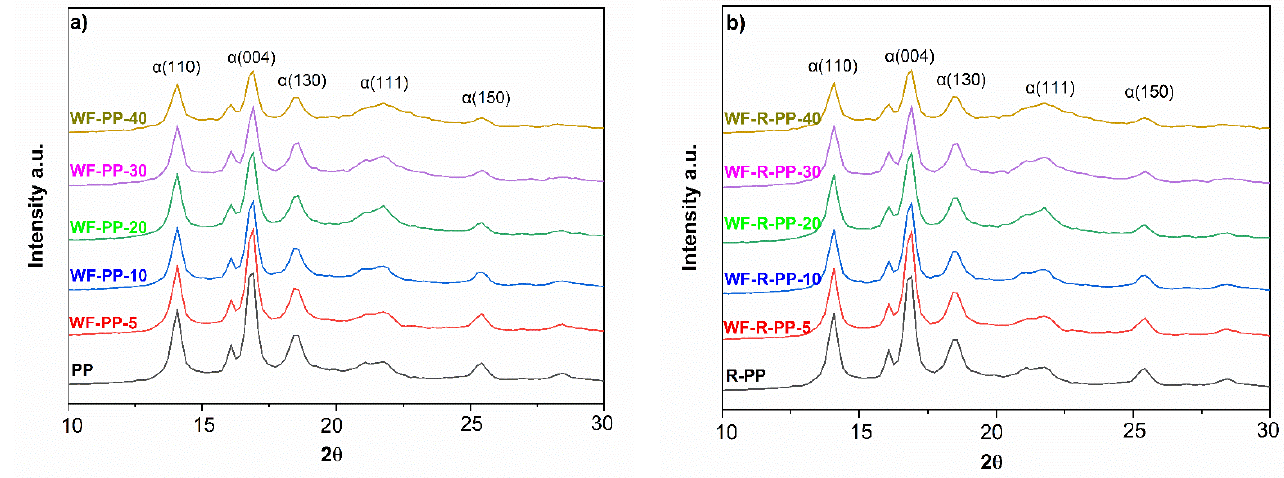
Figure 4. XRD patterns of ( a ) PP, WF-PP composites and ( b ) R-PP, WF-R-PP composites. The elemental composition of the composite surfaces was monitored by ATR-FTIR analysis. The spectra of the injection moulded samples with different addition of WF (from 5%: WF—PP − 5 to 40%: WF—PP − 40) as well as the pure PP and WF, are shown in Figure 5. As can be seen from this Figure 5, the most prominent characteristic fingerprint band vibration at 1030 cm − 1 (associated with the stretching vibrations of different groups in carbohydrates) appeared in the sample with the highest proportion of WF, i.e., 40%. Figure 5 shows the ATR-FTIR spectra of unrecycled PP (PP), wood fibre (WF) and wood fibre-polypropylene composites. The characteristic bands of PP (Figure 5) and R-PP (Figure 5) at 2919 cm − 1 correspond to the asymmetric CH 2 stretching vibration, the band at 2956 cm − 1 to the -CH 3 stretching vibration and 2875 cm − 1 to the asymmetric -CH 2 stretching vibration. The characteristic peaks at 1452 cm − 1 and 1374 cm − 1 were determined as -CH 3 -CH 2 -rocking vibration. In the “fingerprint” region of PP and R-PP, the spectra contain several main PP tacticity, which includes isotactic, syndiotactic and atactic forms. Typical characteristic peaks for isotactic PP are found in the region below 1000 cm − 1 [34,35]. The characteristic vibration bands of WF (red curve) are also shown in Figure 5. WF are composed of cellulose, hemicellulose and lignin [36,37]. Since the wood structure is very complex, the ATR-FTIR spectra were divided into two regions. The first region from 3800 cm − 1 to 2700 cm − 1 includes the OH and CH stretching vibrations. A strong broad peak is seen at 3345 cm − 1 , which has been assigned to various O-H stretching vibrations, while at 2919 cm − 1 a characteristic peak is related to the asymmetric and symmetric methyl and methylene stretching vibrations groups represented in wood. The second, at 1800 cm − 1 to 800 cm − 1 , is known as the “fingerprint” region for various functional groups of the wood structure. The “fingerprint” region of wood consists of several bands related to wood structure. A characteristic peak associated with the C=O stretching vibration in lignin and hemicellulose was observed at 1734 cm − 1 . The characteristic bands at 1508 cm − 1 and 1263 cm − 1 were determined to be C=C, C-O stretching or bending vibrations of the groups in lignin. The bands at 1452 cm − 1 , 1421 cm − 1 , 1371 cm − 1 were assigned to C-H, C-O deformation, bending or stretching vibrations of lignin groups and carbohydrates. The bands at 1023–1051 cm − 1 were assigned to C-O deformation in cellulose, symmetric C-O-C stretching of dialkyl ethers and aromatic C-H deformation in lignin [38,39] generally for carbohydrates from